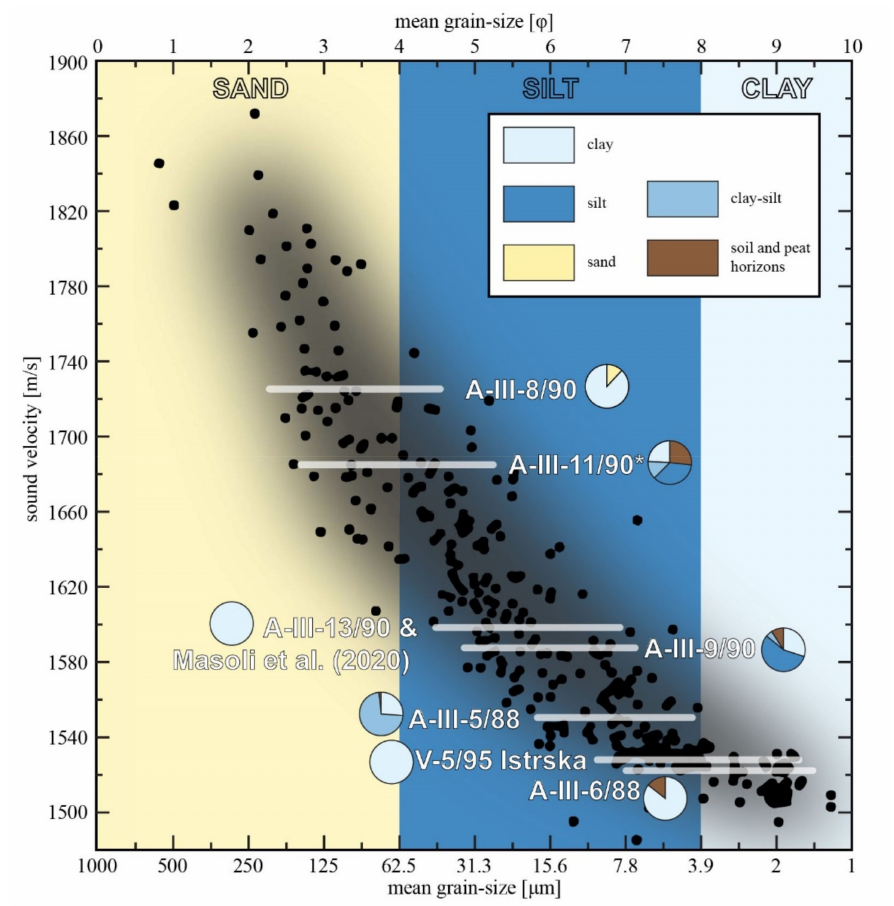
Figure 7. The relation between sound velocity and mean grain size for continental shelf sediments (after [19]) with added velocities from our study. Our estimated sound velocities and the velocity value from [76] for a similar setting in the Gulf of Trieste (see Section 4.3) are shown by white horizontal overlays. Asterisk at Borehole A-III-11 / 90 indicates that this borehole is separated by more than 5 m from the nearest sub-bottom profile. Pie charts display the proportions of sediment types in each borehole core (for details, see Figure